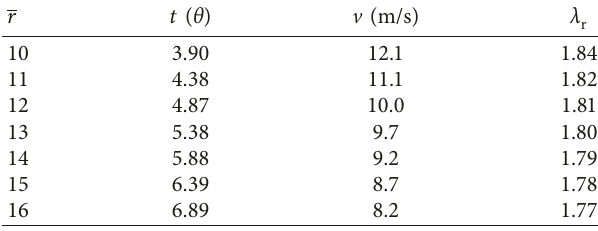
Table 7: The time of the peak pressure occurring, the corre- sponding velocity of the outer shell, and the reflection coefficient with different detonation distances.